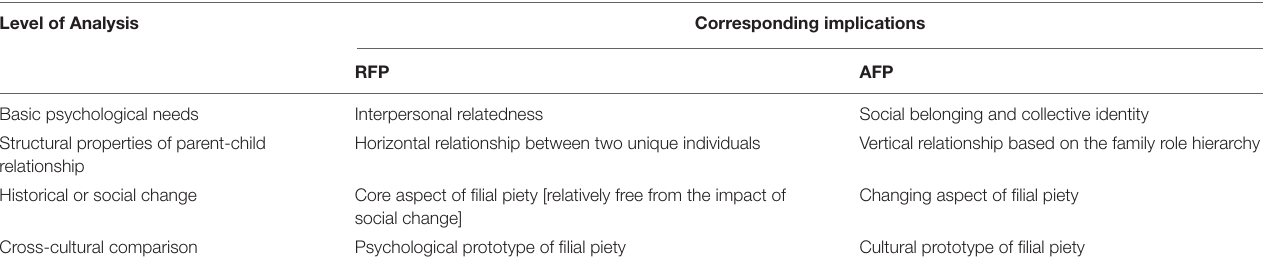
TABLE 2 | Theoretical implications of the DFPM at different levels of